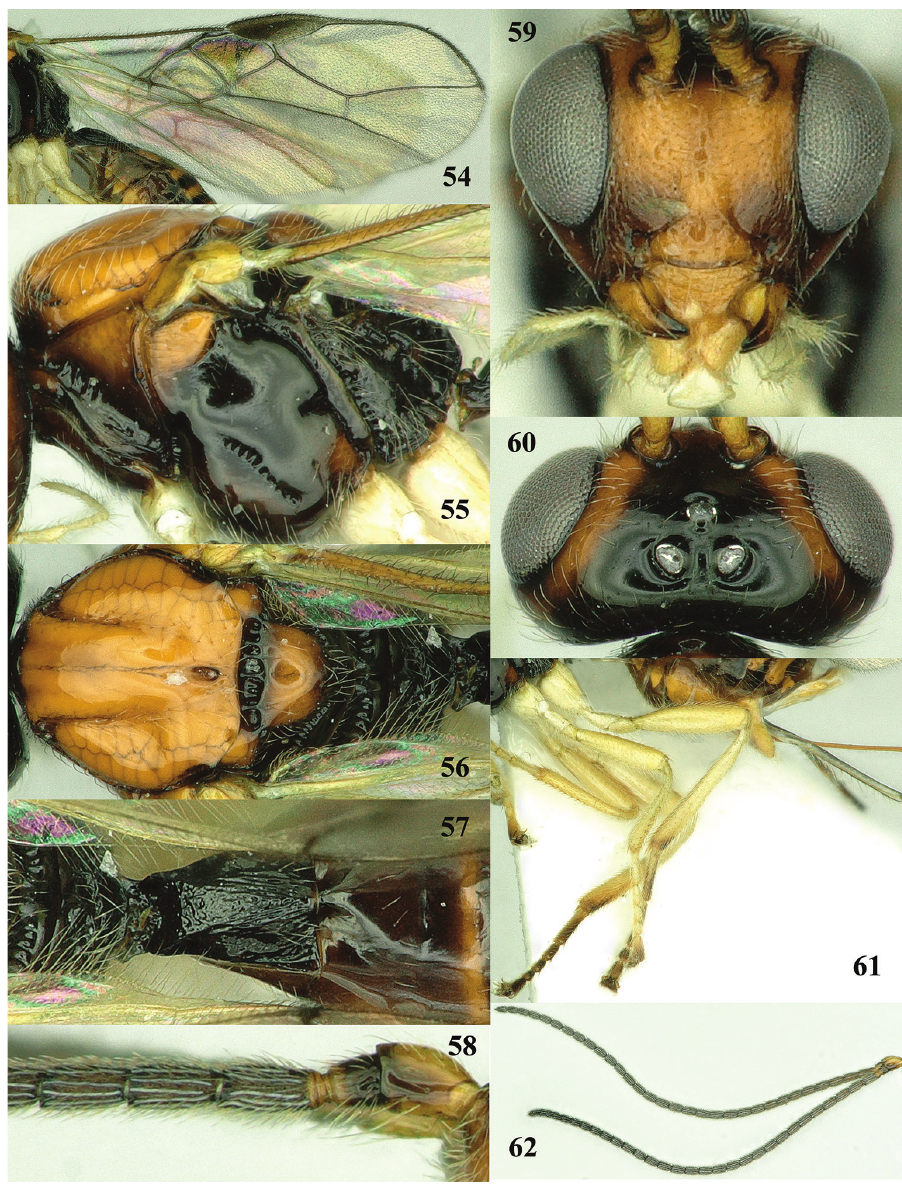
Figures 54–62. Rhogadopsis pratellae (Weng & Chen), female, China, Liupan Mt. 54 wings 55 meso- soma lateral 56 mesosoma dorsal 57 propodeum and first-third metasomal tergites dorsal 58 base of antenna 59 head anterior 60 head dorsal 61 hind leg 62 antenna. tergite; second tergite with pair of large triangular basal depressions; second and follow- ing tergites smooth; length of setose part of ovipositor sheath 0.22 times fore wing and 0.7 times hind tibia (Fig. 53); entire exposed sheath 0.28 times fore